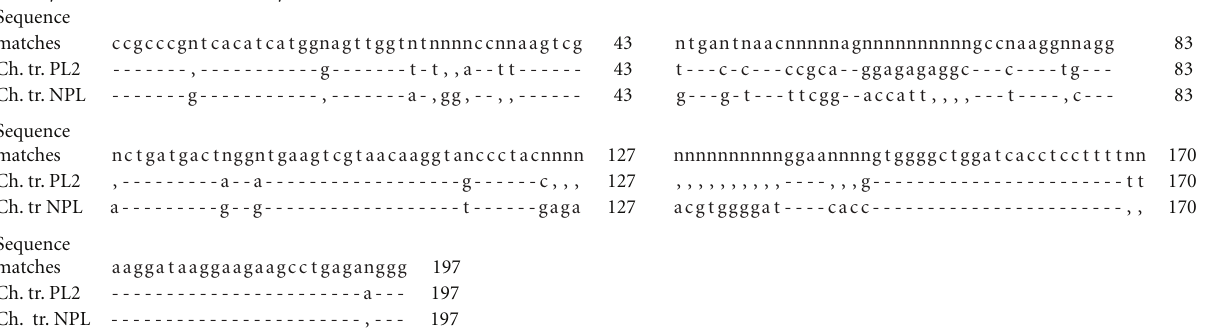
gctgaannccnnnntntggttganggtactacactngcccgcc